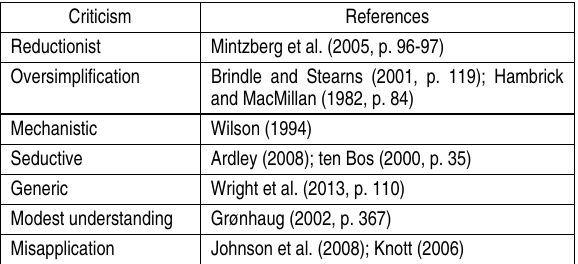
Table 3. Criticism of the BCG Matrix